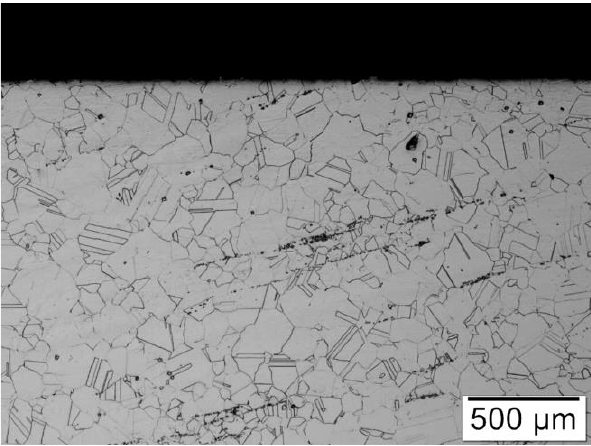
Figure 1: Inconel 718 microstructure [16]